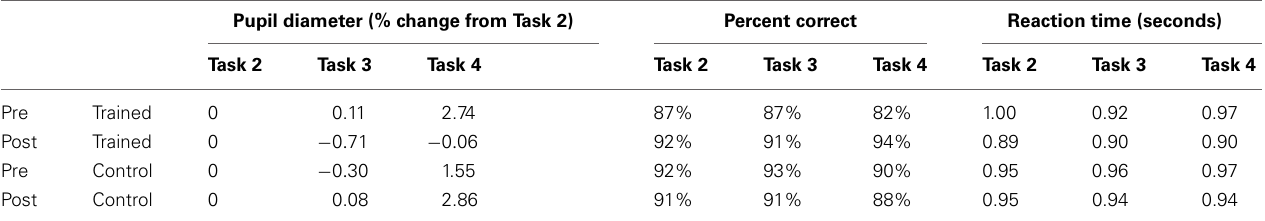
Table 2 | Mean values for behavioral and pupil